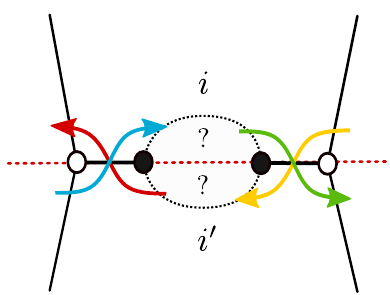
Figure 18. Two edges of a given face on a fixed line, separated by a general structure.